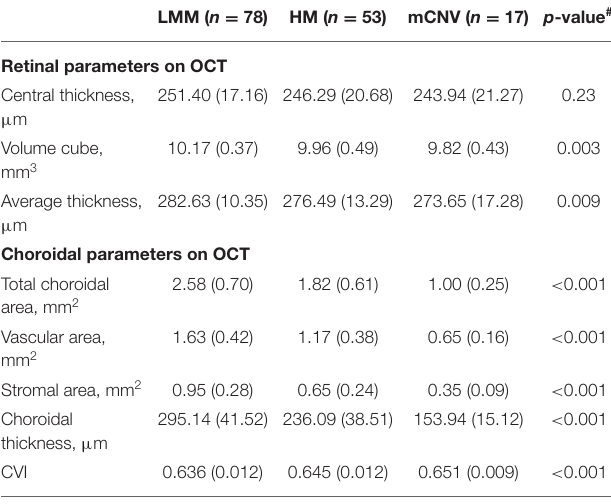
TABLE 3 | Retinal and choroidal morphological and vascular characteristics on OCT in LMM, HM, and mCNV